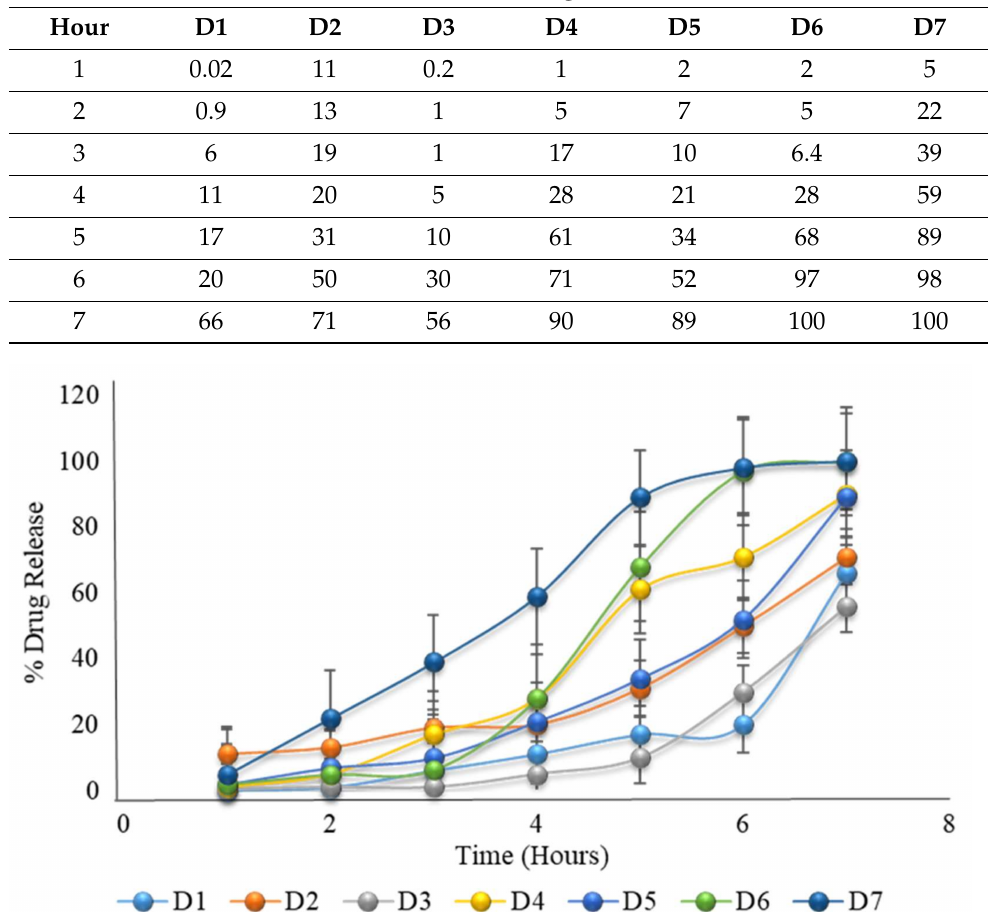
Figure 5. The in vitro dissolution of formulation D1 to D7 (the first 2 h in an acid medium of pH 1.2, and then in a phosphate buffer medium of pH 6.8) showing the desired drug release after a delay time of 5 to 6